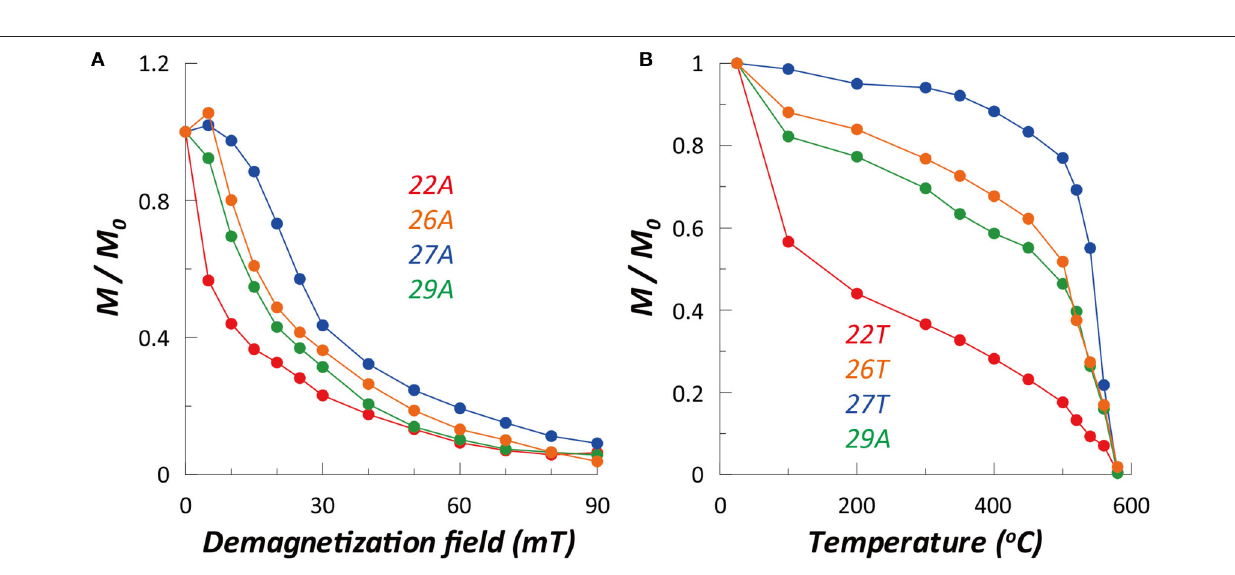
FIGURE 4 | Examples of (A) AF and (B) thermal demagnetization